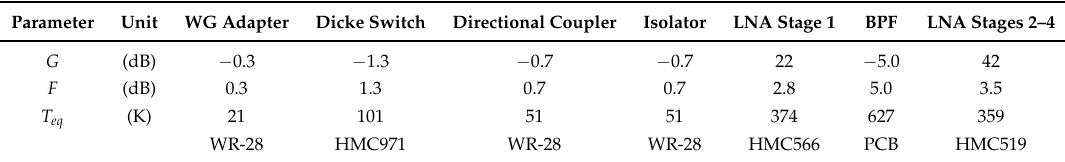
Table 8. 31.4 GHz radiometer building blocks